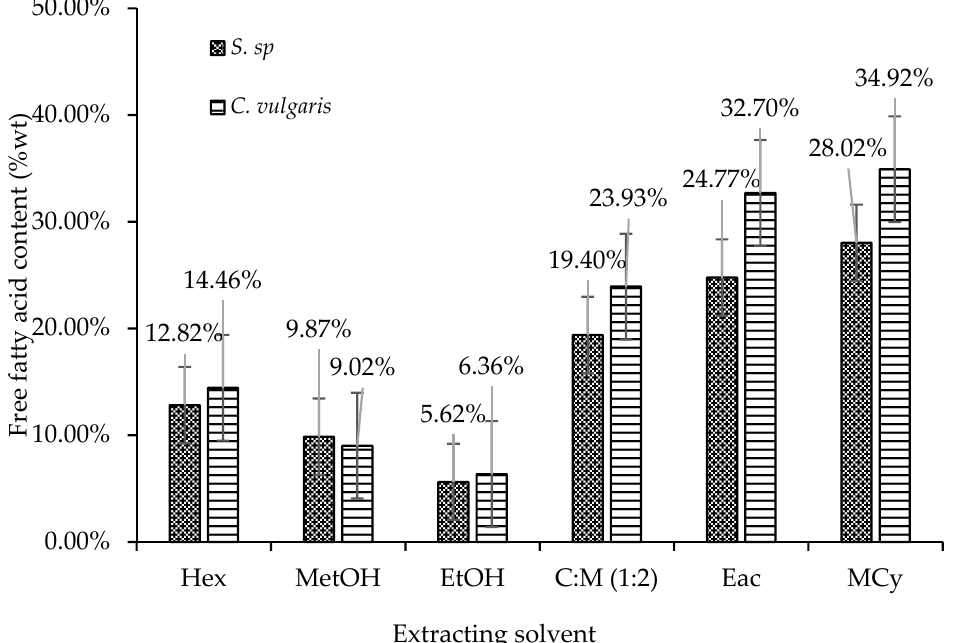
Figure 5. Free fatty acid weight content of Scenedesmus sp. and Chlorella vulgaris growth in pig slaughterhouse wastewater for 11 days and extracted using Hexane (Hex), Methanol (MeOH), Ethanol (EtOH), Chloroform: methanol (1:2) (C:M (1:2)), Ethyl acetate (EAc) and Methylcyclohexane (MCy). The values are presented as means of triplicate measures with their corresponding standard deviation ( ±